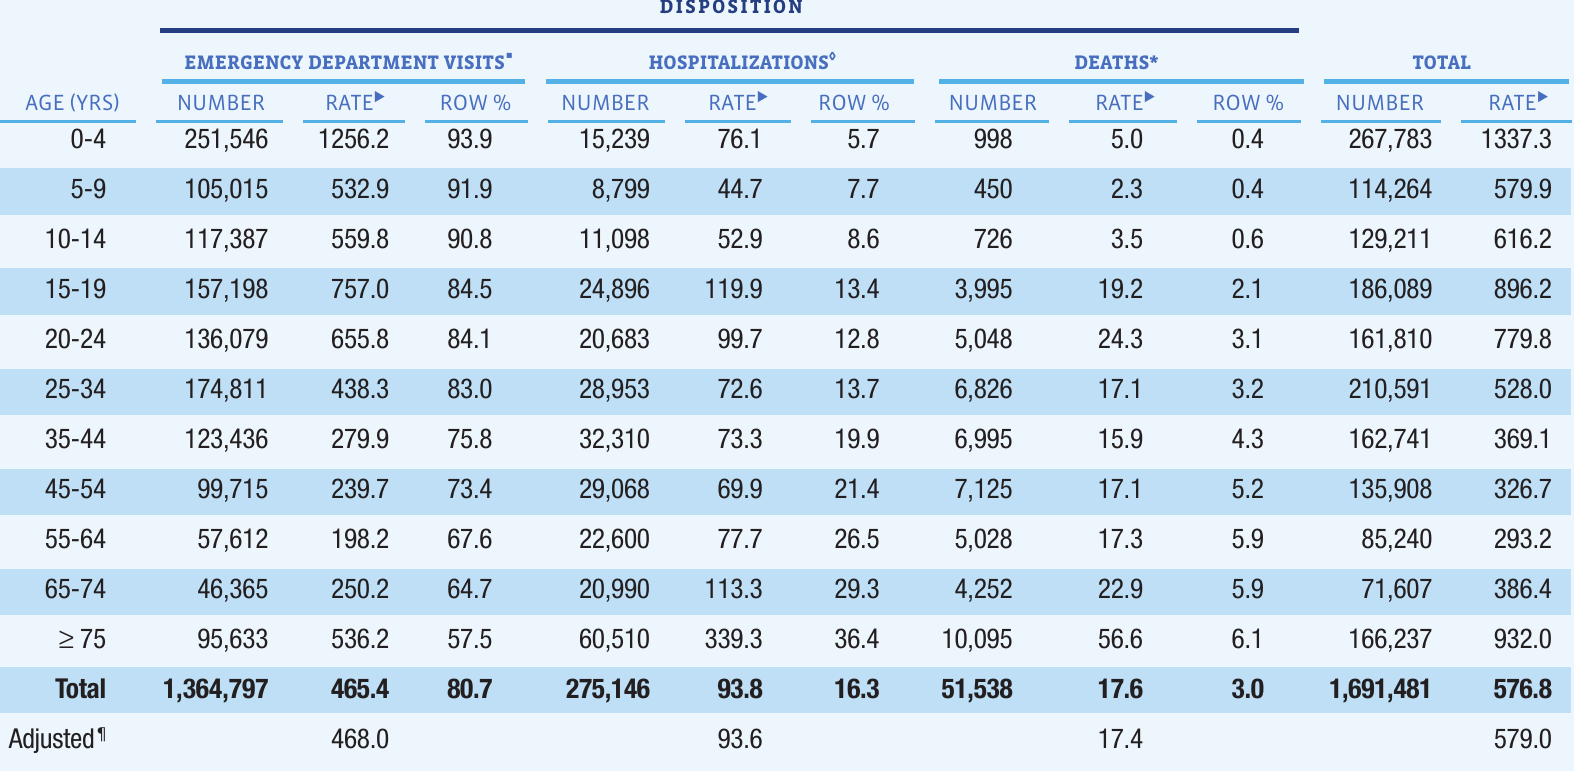
TABLE 1: Estimated Average Annual Numbers, Rates, and Percentages of Traumatic Brain Injury-Related Emergency Department Visits, Hospitalizations, and Deaths, by Age Group, United States,